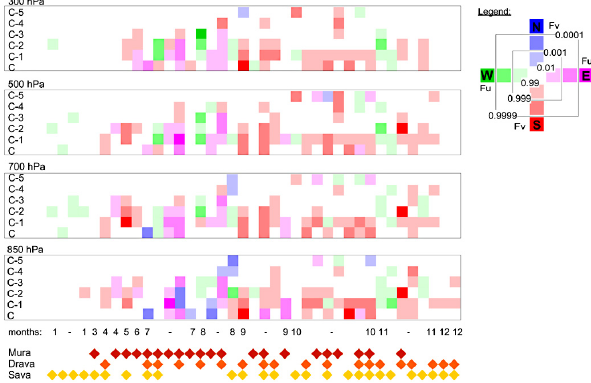
Fig. 3. Daily means of moisture flux components during 1958–2001 at the pixel [15E; 47.5N], and respective values of the cumulative distribution function. Directions of moisture flux components are marked by letters. Extreme values of each component are high- lighted by large signs.